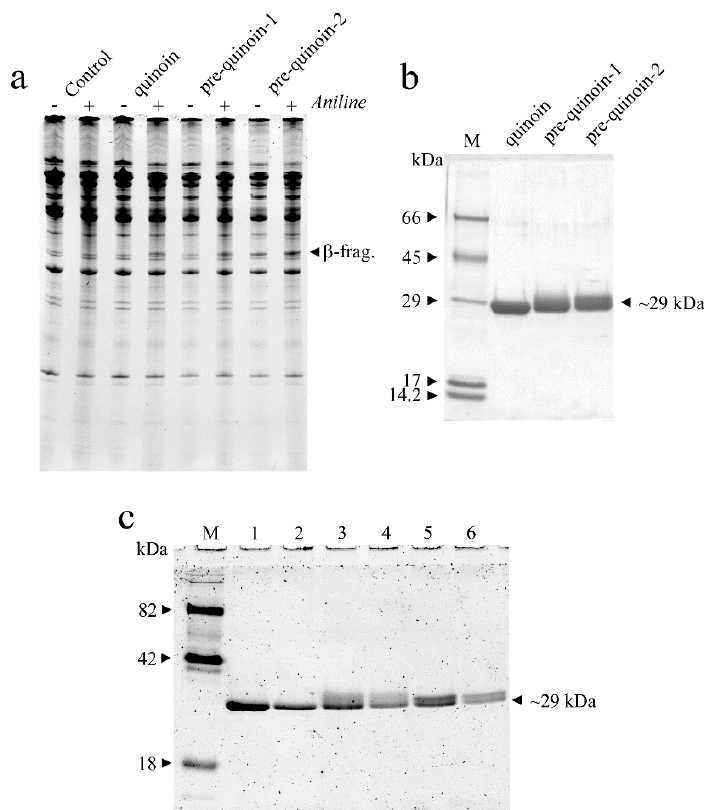
Figure 1. ( a ) rRNA N-glycosylase activity of quinoin, pre-quinoin-1 and pre-quinoin-2 on rabbit ribosomes. rRNA N-glycosylase activity was assayed as indicated in the ‘Material and Methods’ section. Each lane contained 3.0 μ g of RNA isolated from either untreated (control) or RIP treated ribosomes from a rabbit. β -frag. indicates the RNA fragment (Endo’s fragment) released as a result of RIP action after acid aniline treatment (+); ( − ) without aniline treatment. ( b ) Analysis by SDS-PAGE of the three RIPs isolated from C. quinoa seeds. M, marker proteins. SDS-PAGE was carried out in 12% polyacrylamide separating gel under reducing conditions. ( c ) A total of 3.0 and 1.5 μ g of quinoin (lane 1 and 2, respectively), pre-quinoin-1 (lane 3 and 4, respectively) and pre-quinoin-2 (lane 5 and 6, respectively) were run on 12% SDS-PAGE under reducing conditions, followed by in-gel glycan detection using the Pro-Q Emerald 300 glycoprotein staining kit. Stained proteins were visualised by UV trans-illumination. M, CandyCane™ glycoprotein molecular weight standards.